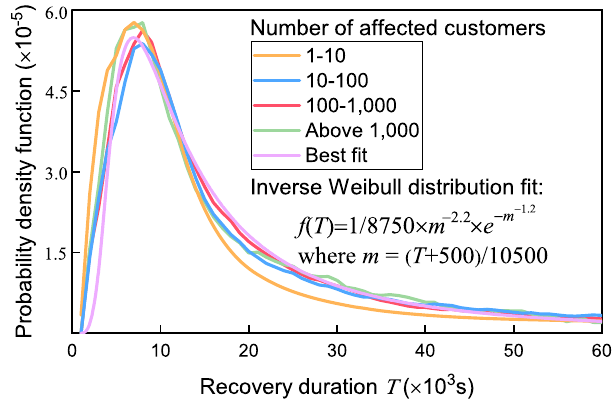
Fig.1|Probabilitydensityfunctionofrecoveryduration. Fourgroupsofoutages with different number of affected customers are plotted. The similarity of the four curves, fi tted by a universal inverse Weibull distribution function, illustrates the independencebetweentheoutage ’ srecoverydurationandthenumberofaffected